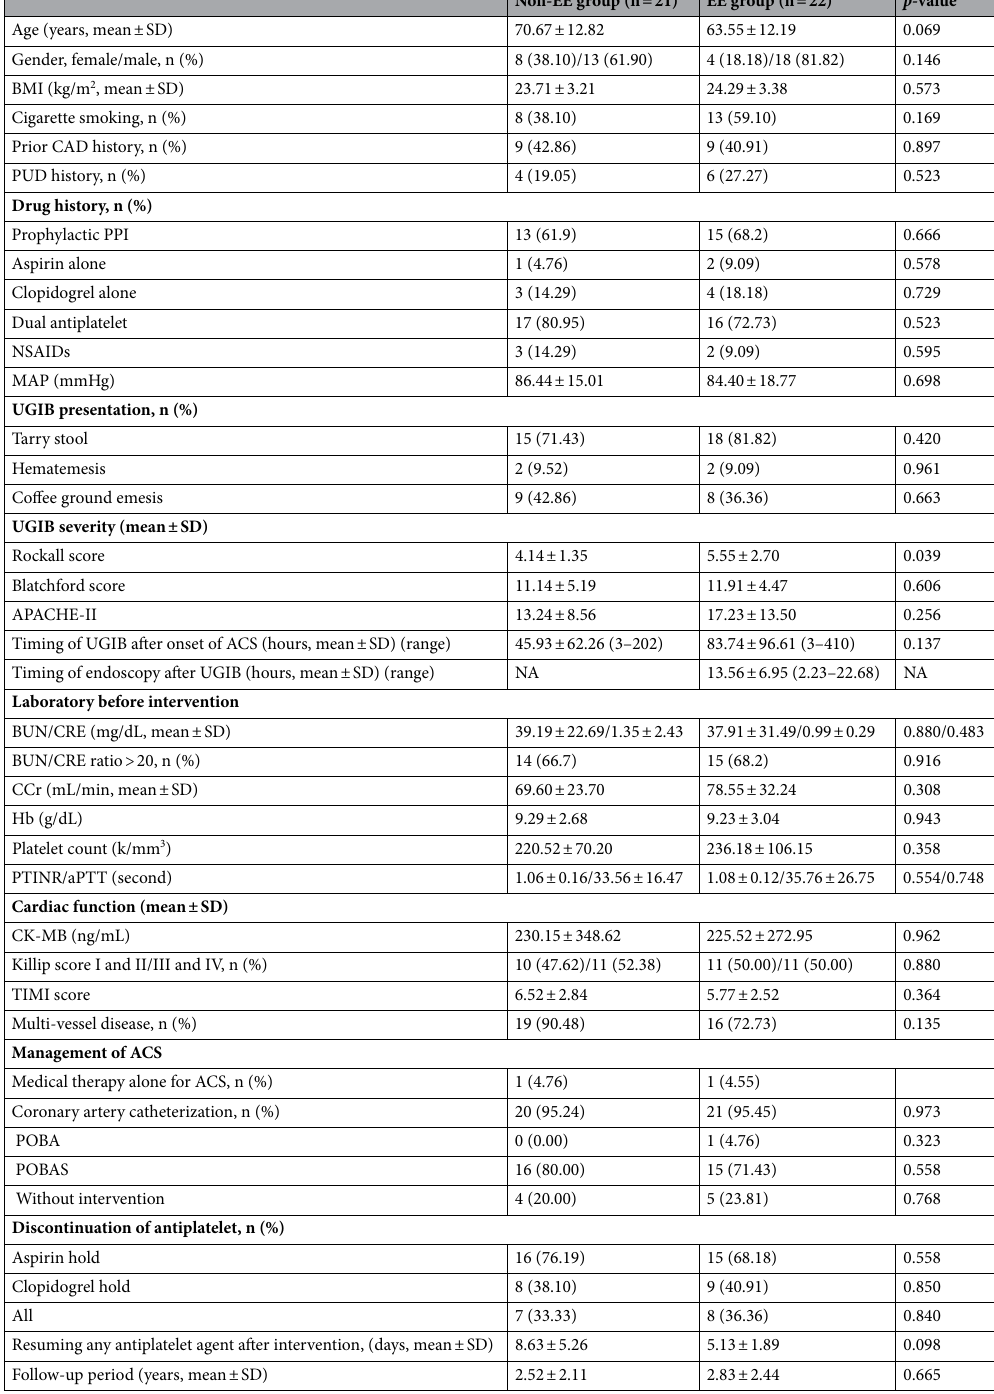
Table 1. Demographic data of enrolled patients. APACHE‑II Acute Physiology and Chronic Health Evaluation-II, aPTT activated partial thromboplastin time, BMI body mass index, BUN blood urea nitrogen, CAD coronary artery disease, CCr creatinine clearance rate, CRE creatinine, Hb hemoglobin, EE early endoscopy, MAP mean arterial pressure, NSAID non-steroid anti-inflammatory drug, POBA percutaneous old balloon angioplasty, POBAS percutaneous old balloon angioplasty with stent, PPI proton pump inhibitor, PTINR prothrombin time international normalized ratio, PUD peptic ulcer disease, SD standard deviation, TIMI Thrombolysis In Myocardial Infarction, UGIB upper gastrointestinal bleeding.